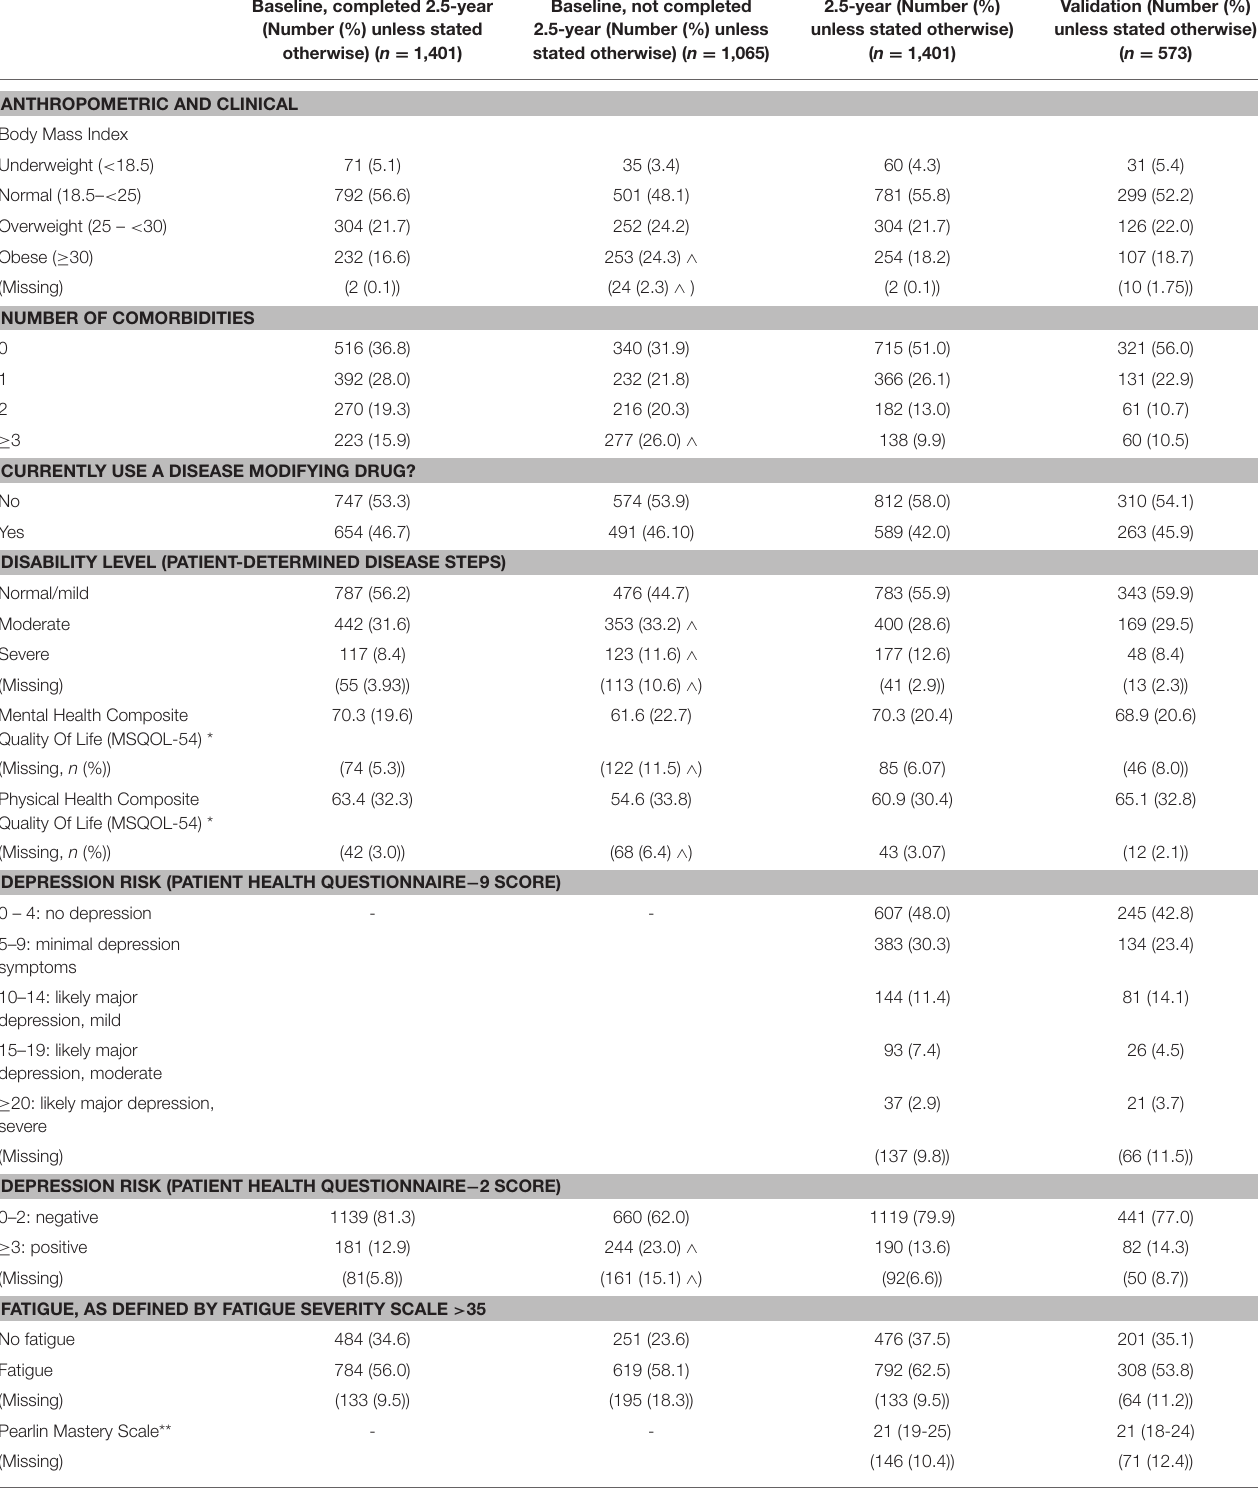
TABLE 2 | Anthropometric and clinical characteristics of the 2.5-year and validation cohorts and the baseline characteristics of the participants who completed and were lost to follow-up at 2.5-year